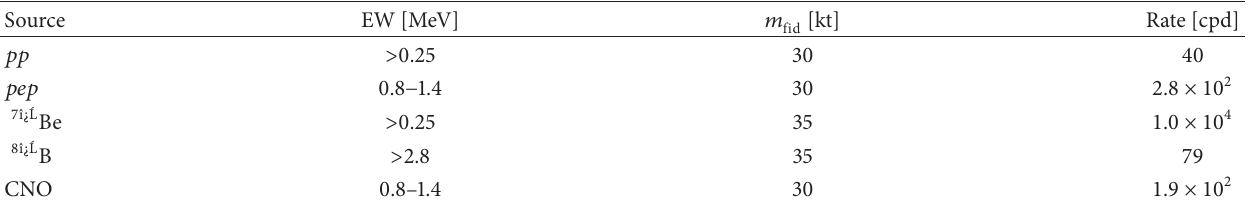
Table 9: Expected solar neutrino rates in LENA (channel 𝜈𝑒 → 𝑒𝜈 ). The estimates are derived from the existing Borexino analyses [154, 188] as well as expectation values for the respective energy windows (EW) of observation [189–191]. The quoted fiducial masses, 𝑚 based on a Monte Carlo simulation of the external 𝛾 -ray background in LENA. Table taken and adapted from